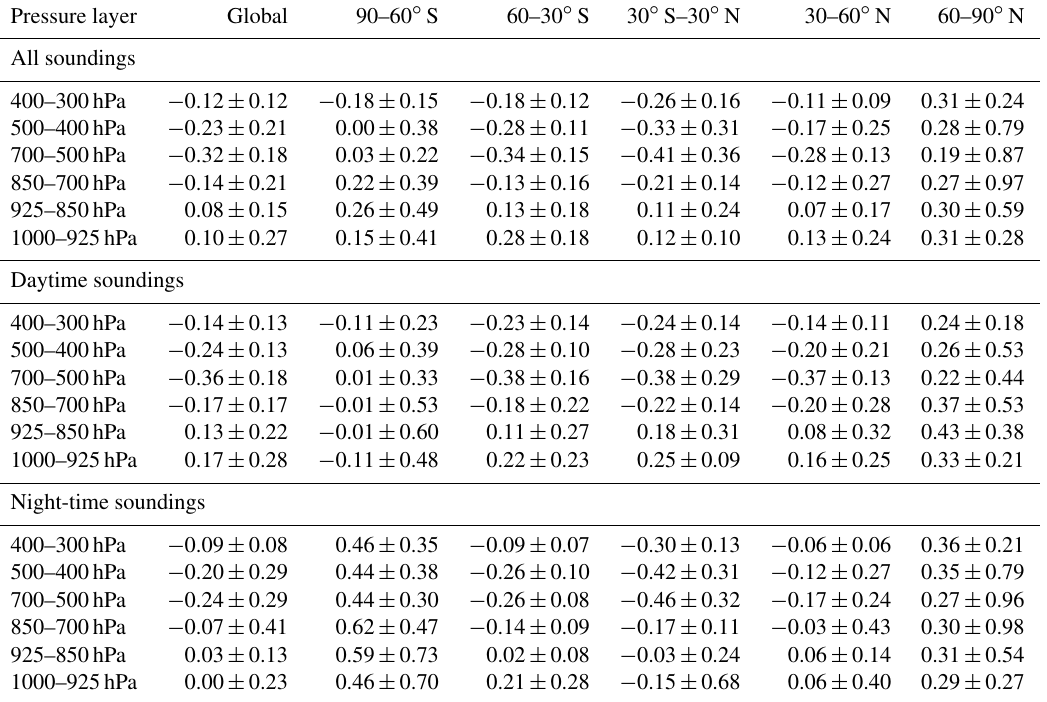
Table 4. As Table 3 but for temperature profile biases. Trends are given in kelvin per decade. Pressure